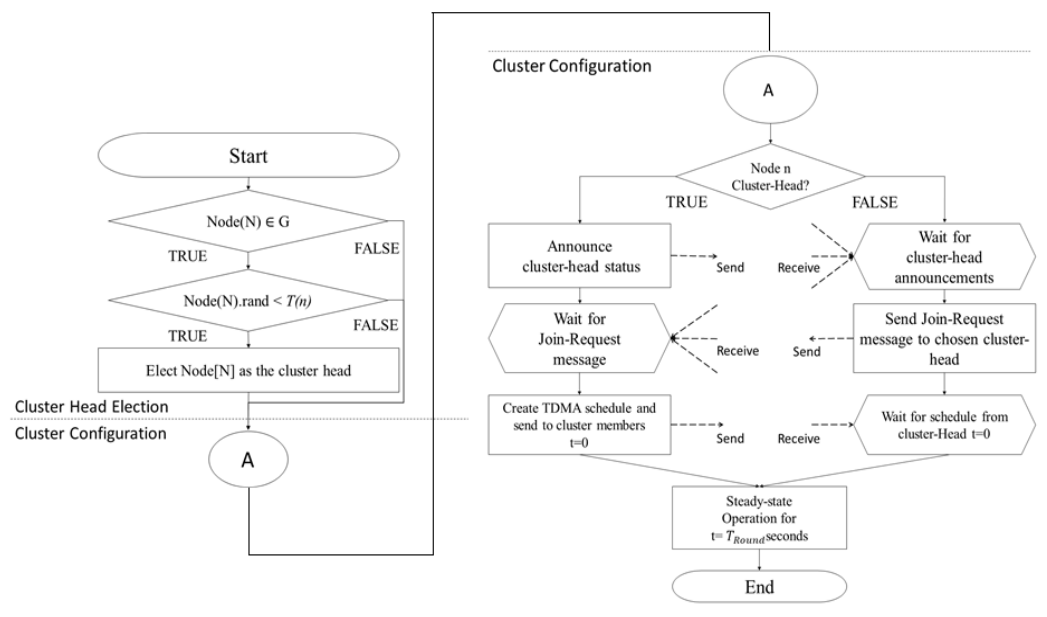
Figure 3. One round of flow-chart of LEACH. Table 1. Change in the selection probability for being CH due to residual